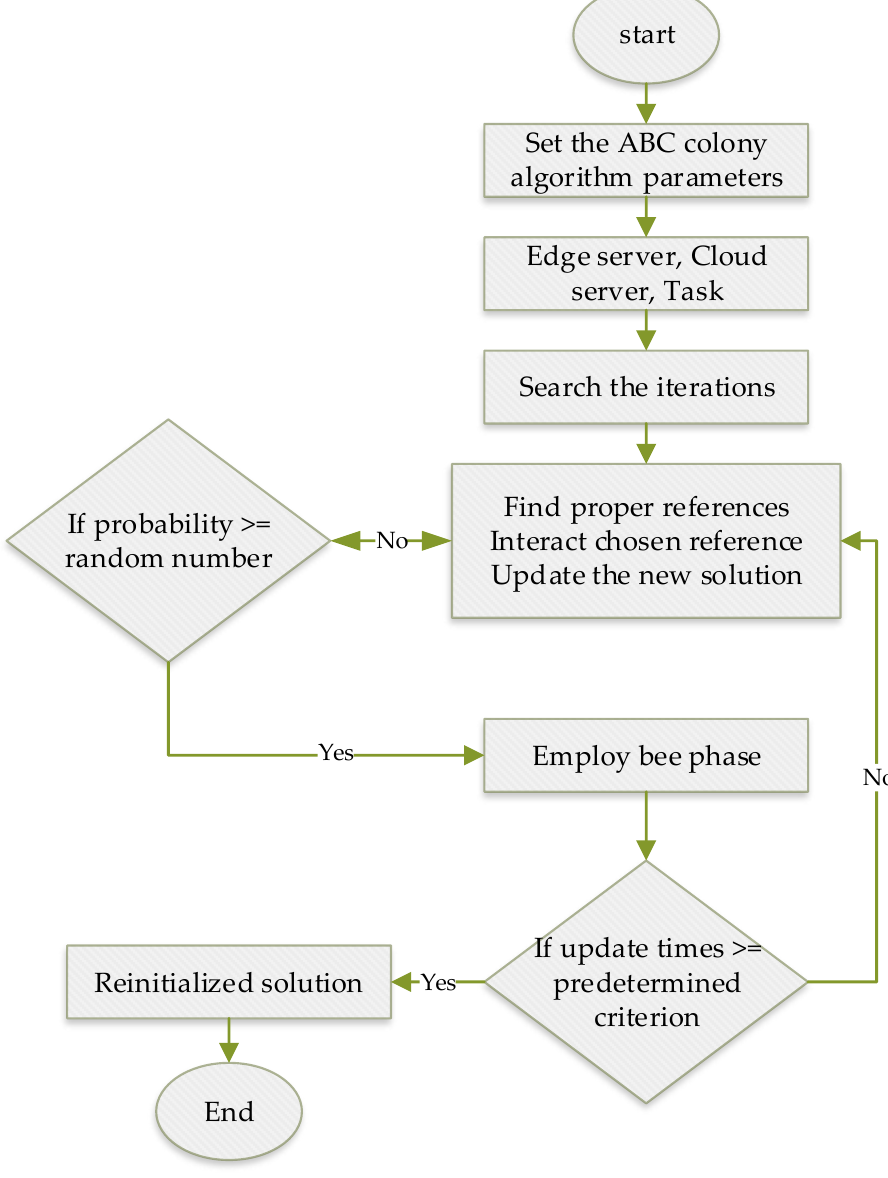
Figure 8. Artificial bee colony